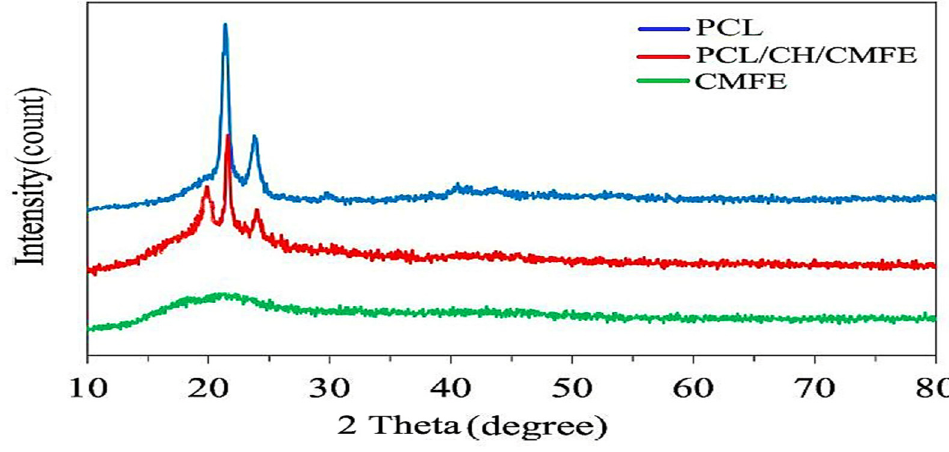
Figure 2. XRD patterns for polycaprolactone (PCL), Cordia myxa fruit extract (CMFE), and PCL/CH/CMFE composite nanofibers.